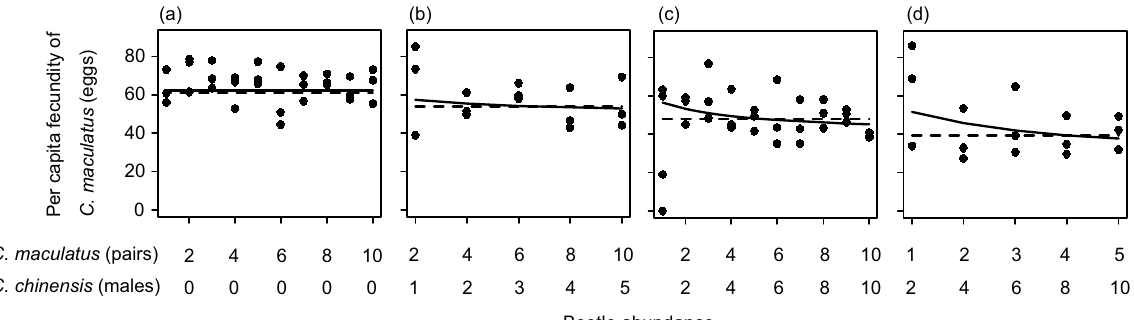
Figure 2. Comparison of experimental data and predictions of the fitted model at different frequencies of C. maculatus and C. chinensis . In each panel, per capita fecundity of C. maculatus , including zero-fecundity data, is plotted against total beetle density with identical C. maculatus : C. chinensis ratio; 1:0 in ( a ), 2:1 in ( b ), 1:1 in ( c ) and 1:2 in ( d ). The solid line represents the prediction of the generalized model (equation (11) with H = 0). The broken line represents the prediction of the conventional model (equation (12) with H = 0). For graphical purposes, we show per capita fecundity and not total fecundity. Estimated parameters: ( R 0 , a , b , c ) = (58.3, 0.119, 0.275, 0.0162) for equation (11) and ( R 0 , i , c ) = (57.4, 0.272, 0.0156) for equation (12). The date was set to the median of dates (day 230) in drawing model predictions. Note that the scales of the horizontal axes are not the same between